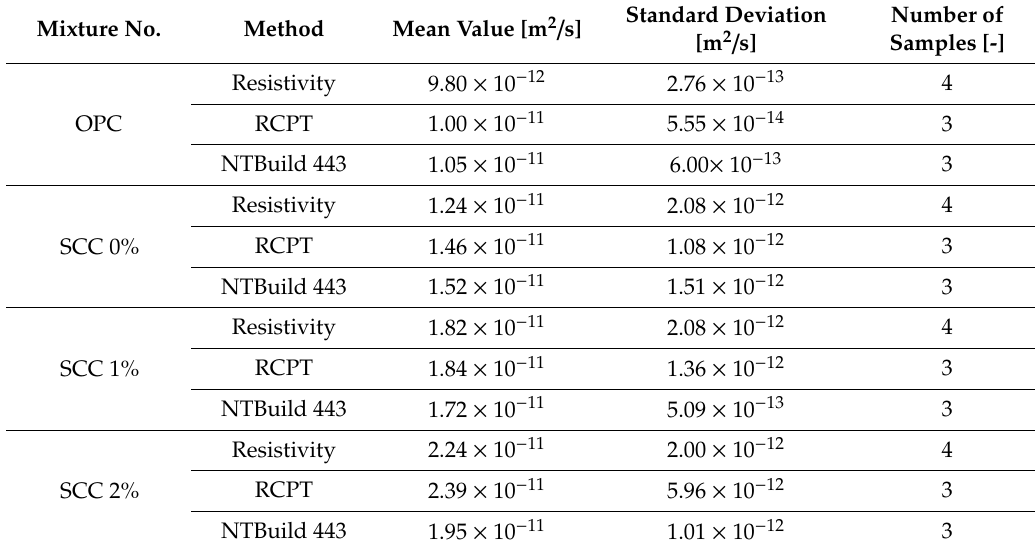
Table 2. Statistical data of di ff usion coe ffi cient D c ( t ) derived from surface resistivity, rapid chloride permeability test (RCPT) and chloride profile analysis (NTBuild